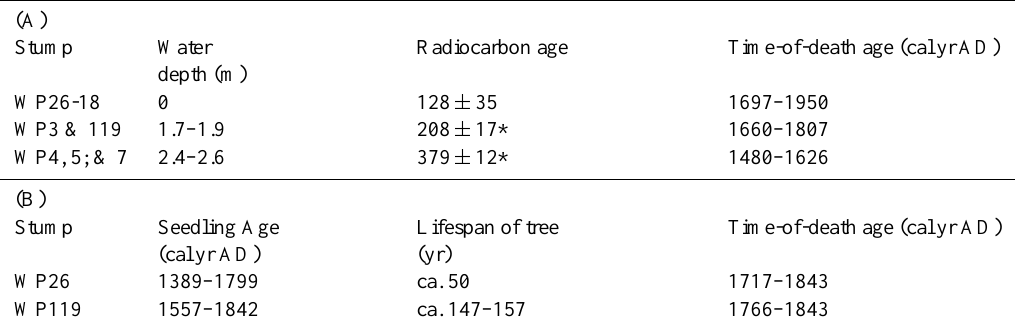
Table 2. (A) Tree stumps located at given water depths in Lake Poerua and their time-of-death ages. (B) OxCal modelled time-of-death and seedling ages for WP26 and